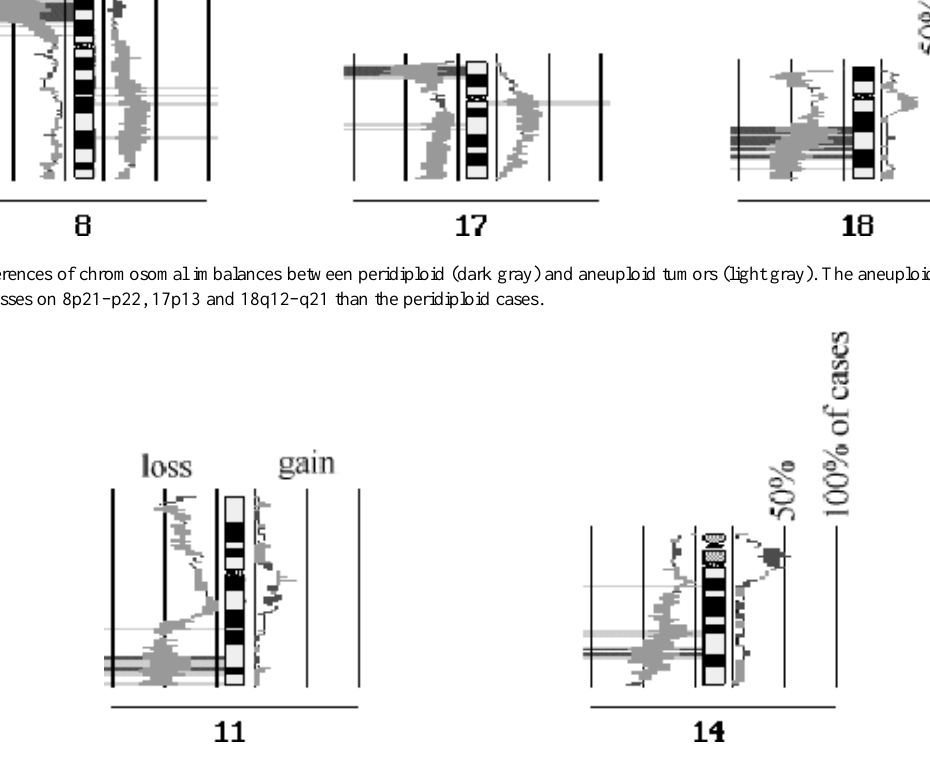
Fig. 9. Differences of chromosomal imbalances between peritetraploid (dark gray) and aneuploid tumors (light gray). The analysis reveals more losses on 11q23 and 14q23–q24 in the aneuploid tumors than in the peritetraploid